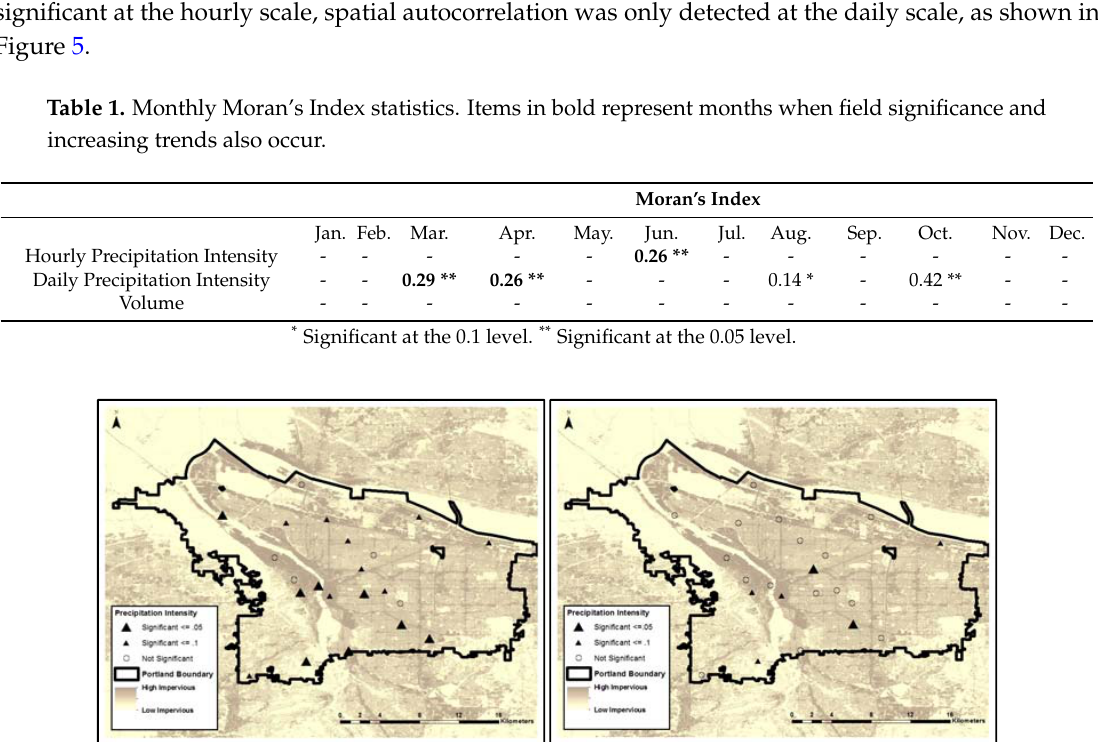
Figure 5. Spatial pattern of precipitation intensity trends for March ( a ) hourly; and ( b ) daily records. Spatial autocorrelation was detected in trends from daily records.